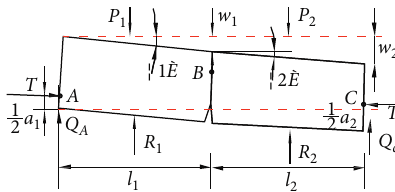
Figure 10: The movement structure and force of two key